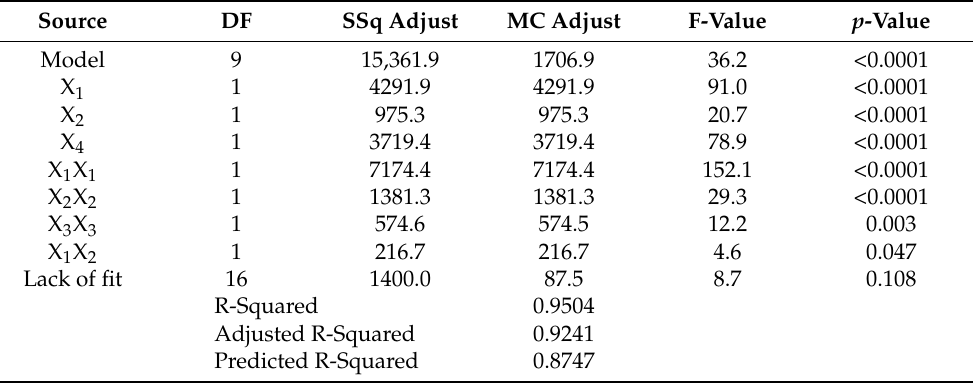
Table 2. Estimated regression coefficients, model adequacy checking, and ANOVA analysis of the